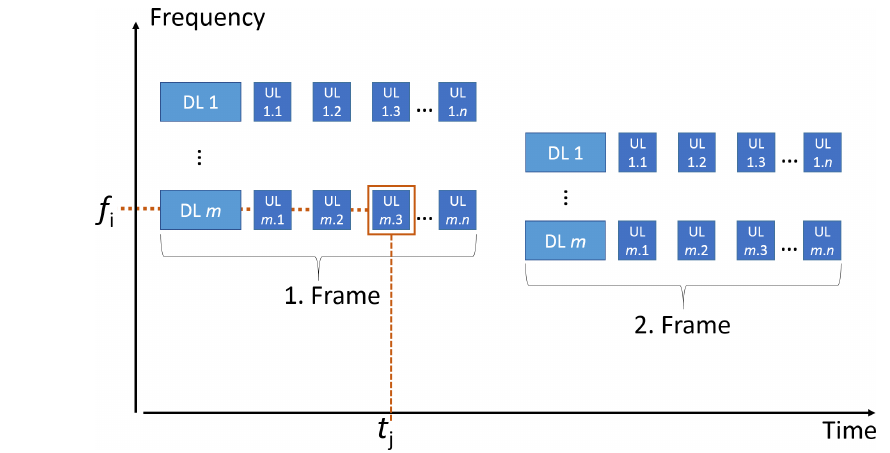
Figure 8. Generic sketch of a (half-duplex) F/TDMA communication system. The frequencies change between the frames in this example.